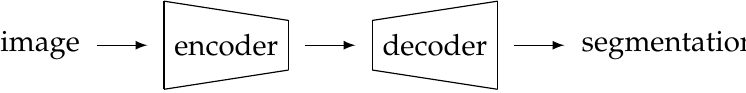
Figure 2. Generic segmentation network.